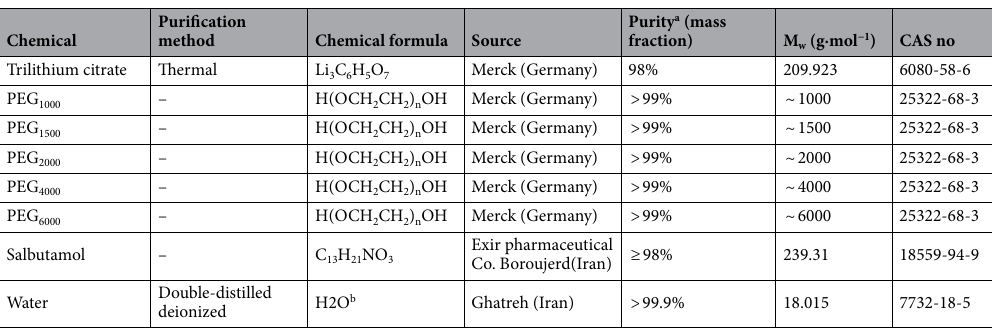
Table 1. Chemicals used in this work. a Purity as provided by suppliers. b Double-distilled deionized water with the conductivity of 0.7 μ S ·cm −1 was